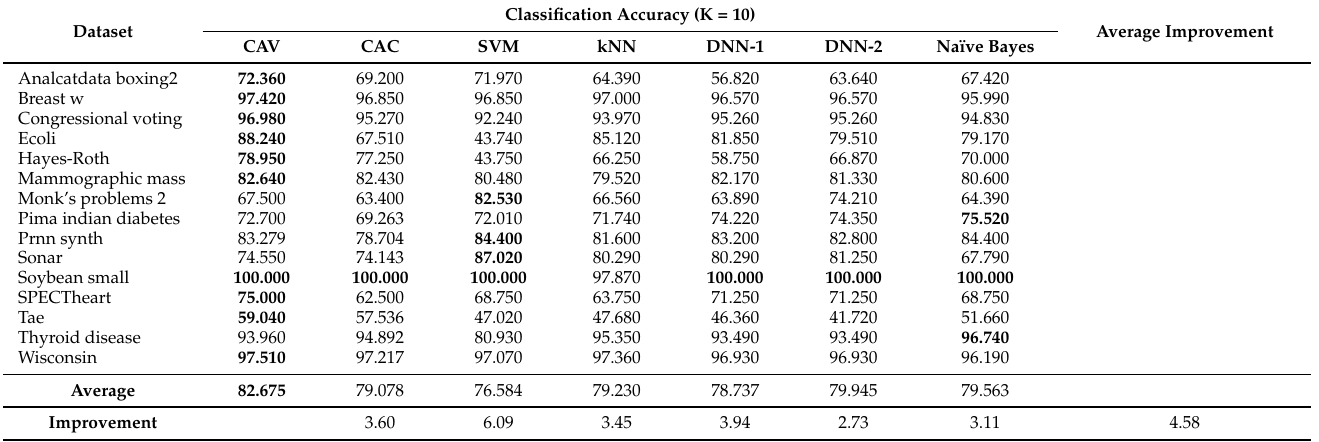
Table 4. The accuracy of the proposed CAV compared with CAC, SVM, k-NN, DNN-1, DNN-2, and naïve Bayes (the bold number indicates the maximum